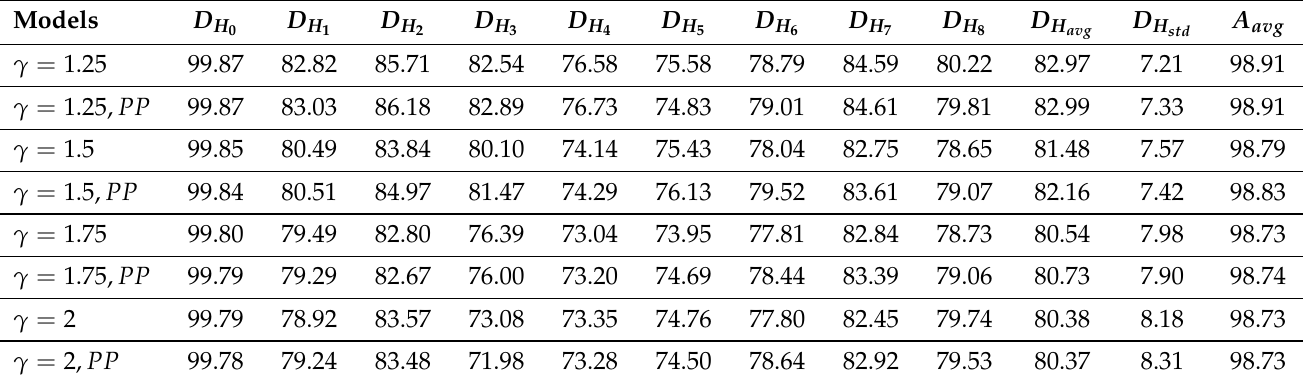
Table 5. Results for the models trained with the FDL W formulation, as defined in Equation (10). Comparisons for the different liver segments. PP stands for Post-Processing. D H coefficient for class t . It is reported as a percentage. D H standard deviation of D H . The average accuracy is denoted as A avg . t